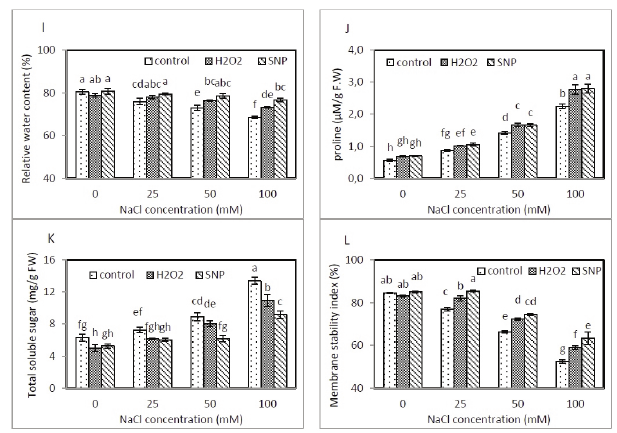
Fig. 2 - Effect of salt treatment and application of exogenous H O and SNP on relative water content (I), proline (J), 2 2 total soluble sugar (K) and membrane stability index (L). Three plants were analyzed for each treatment. Data shown are the mean (±SE) of three independent experi- ments. Significant differences among treatments were determined by Tukey's Test